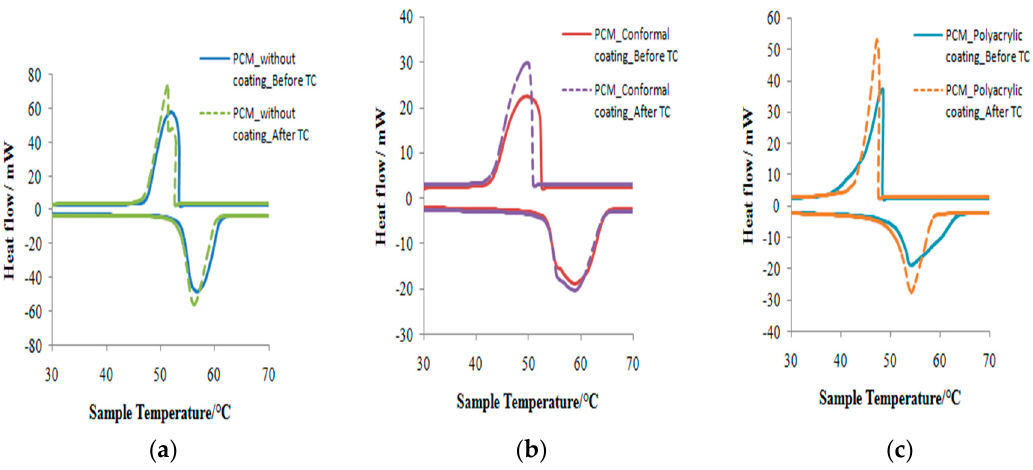
Figure 9. DSC curves of ( a ) PCM without coating; ( b ) PCM with conformal coating and ( c ) PCM with polyacrylic coating before and after 1000 thermal cycling. Table 3. DSC results before and after 1000 thermal cycling.